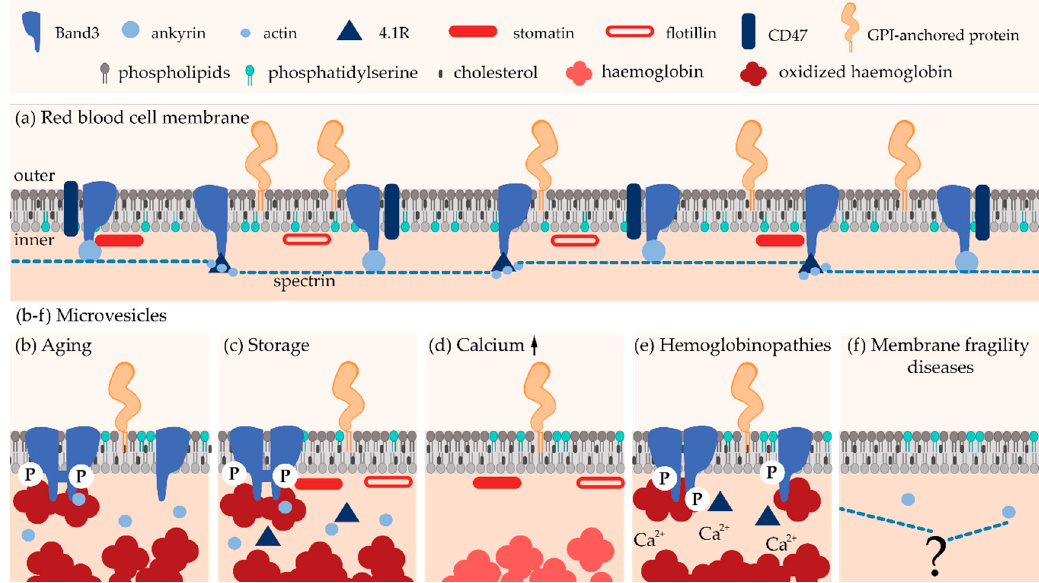
Figure 3. Schematic representation of lipid and protein composition of red blood cell-derived microvesicles. ( a ) RBC plasma membrane. ( b – f ) RBC-derived microvesicles in ( b , c ) physiological processes (senescence in vivo and storage at 4 °C), ( d ) pharmacological Ca 2+ boost, and ( e , f ) pathological situations (hemoglobinopathies and membrane fragility diseases).